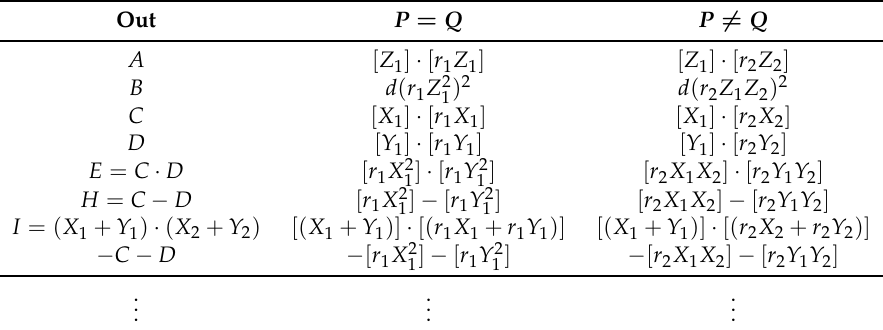
Table A4. Unified point addition for the Edwards elliptic